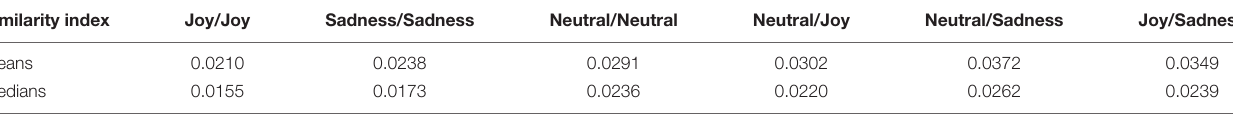
TABLE 2 | Means and medians of intra- and inter-emotional similarity indexes for joy, sad, and neutral